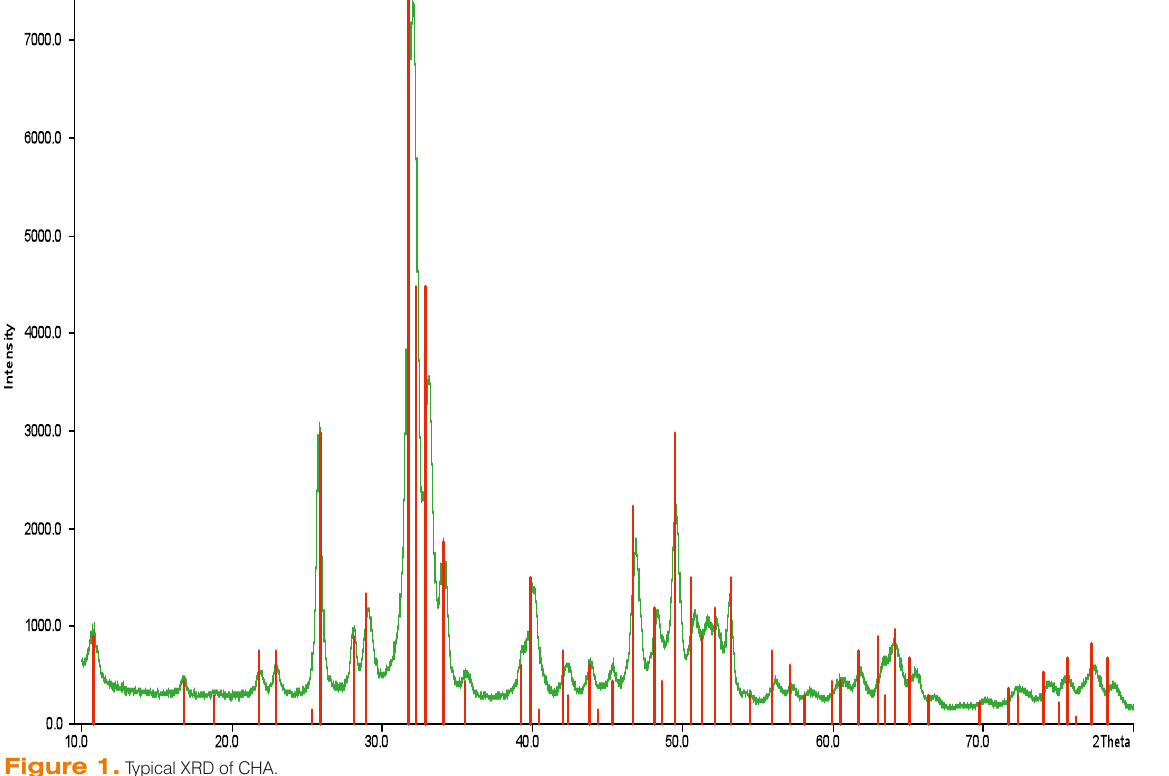
Figure 1. Typical XRD of